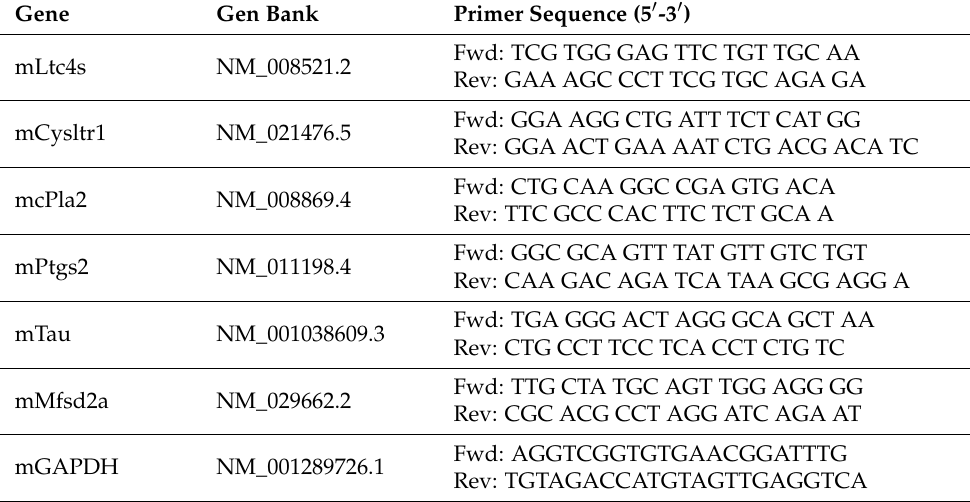
Table 1. Primers for